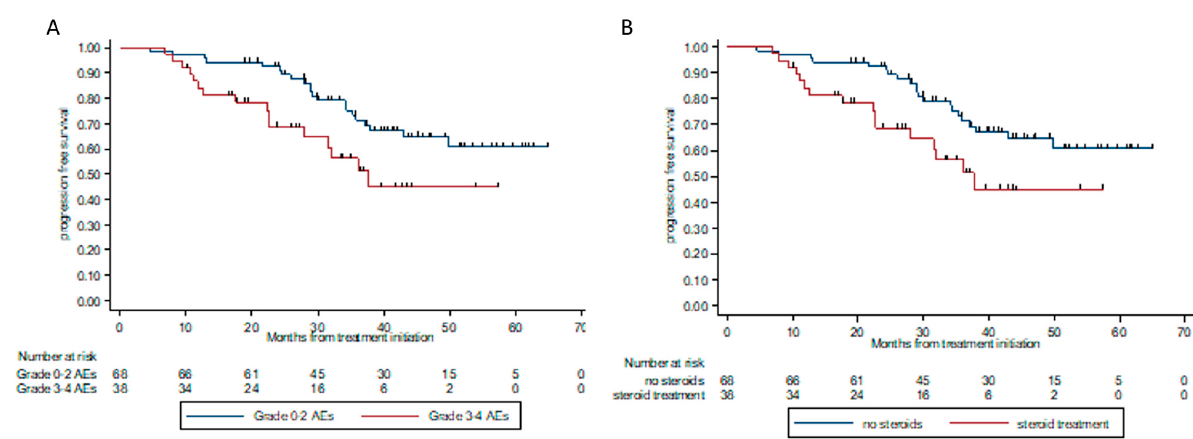
Figure 6. Progression-free survival according to grade of toxicity ( A ) and exposure to steroidal treatment ( B ). ( A ). PFS according to the grade of toxicity. Patients who experienced grade 0–2 AEs had median PFS NR, whereas patients who experienced high grade (grade 3–4) AEs had median PFS of 37 m. HR for PFS was 2.12 (95% CI 1.1–4.1, p = 0.025). ( B ). PFS according to exposure to steroidal treatment. Patients who were exposed to steroids higher than 10 mg prednisolone (or equivalent) had median PFS of 37.6 m, whereas patients with no steroid exposure or ≤ 10 mg prednisolone (or equivalent) had median PFS NR. HR for PFS 2.85 (95% CI 1.4–5.8), p = 0.004.